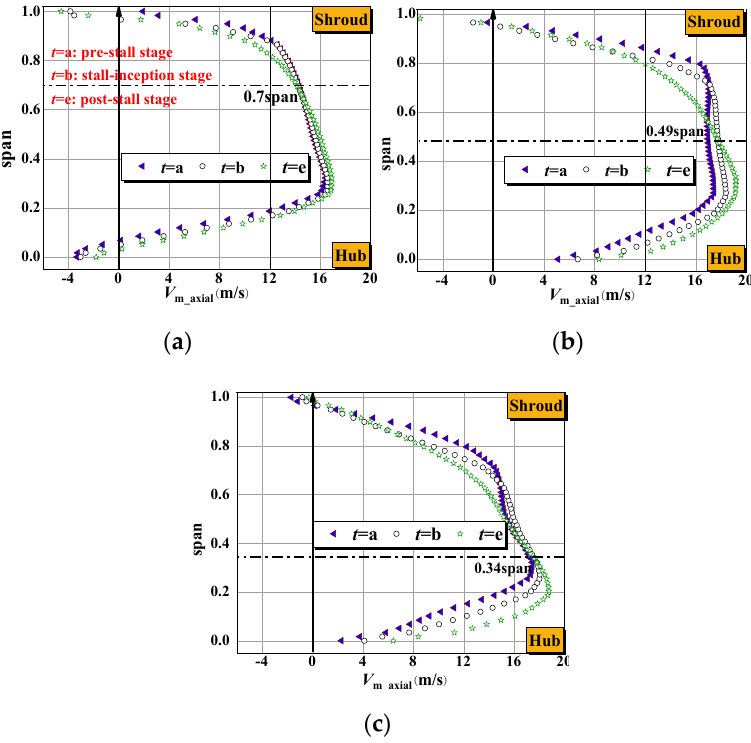
Figure 15. Axial meridional velocity distribution characteristics at different cross-sections: ( a ) inlet surface, ( b ) middle surface, ( c ) outlet surface.